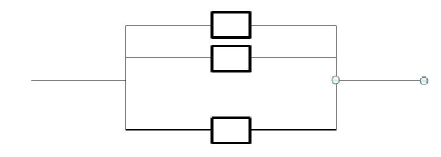
Fig. 3. Parallel system with resource